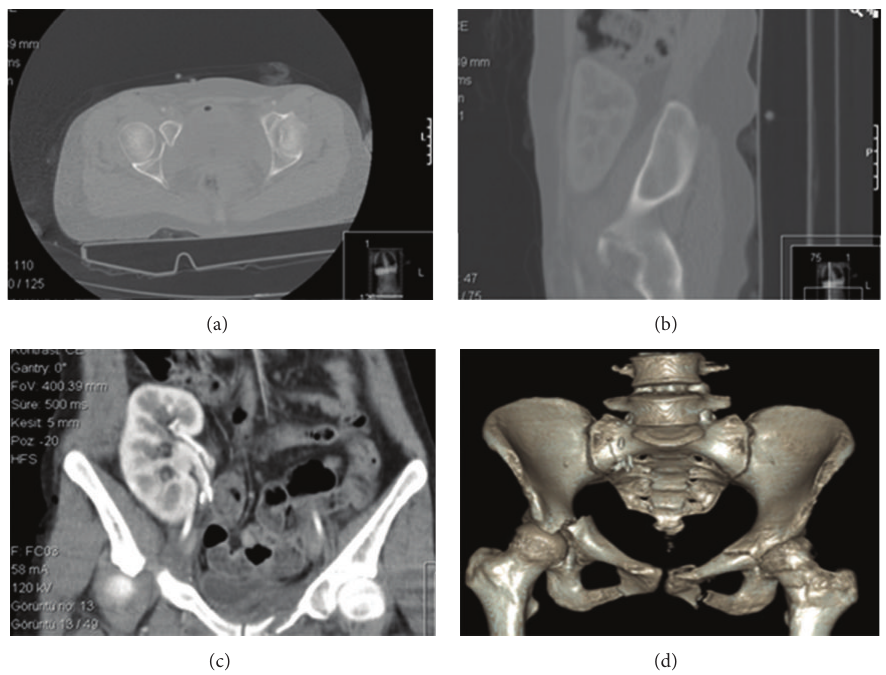
Figure 2: (a, b) Computed tomography (CT) showing the fracture of acetabulum. (c) Transplanted kidney is seen at coronal section of CT. (d) 3D CT view of